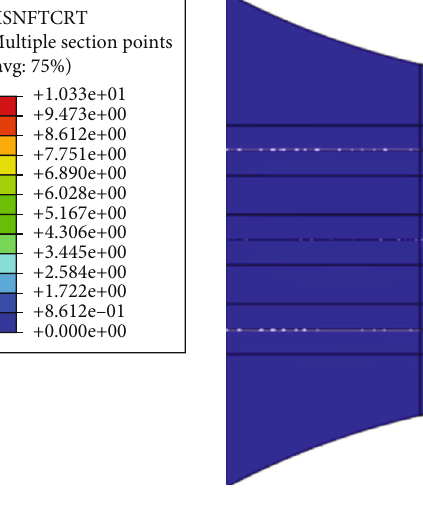
Figure 9: Fiber tensile damage initiation in the standard